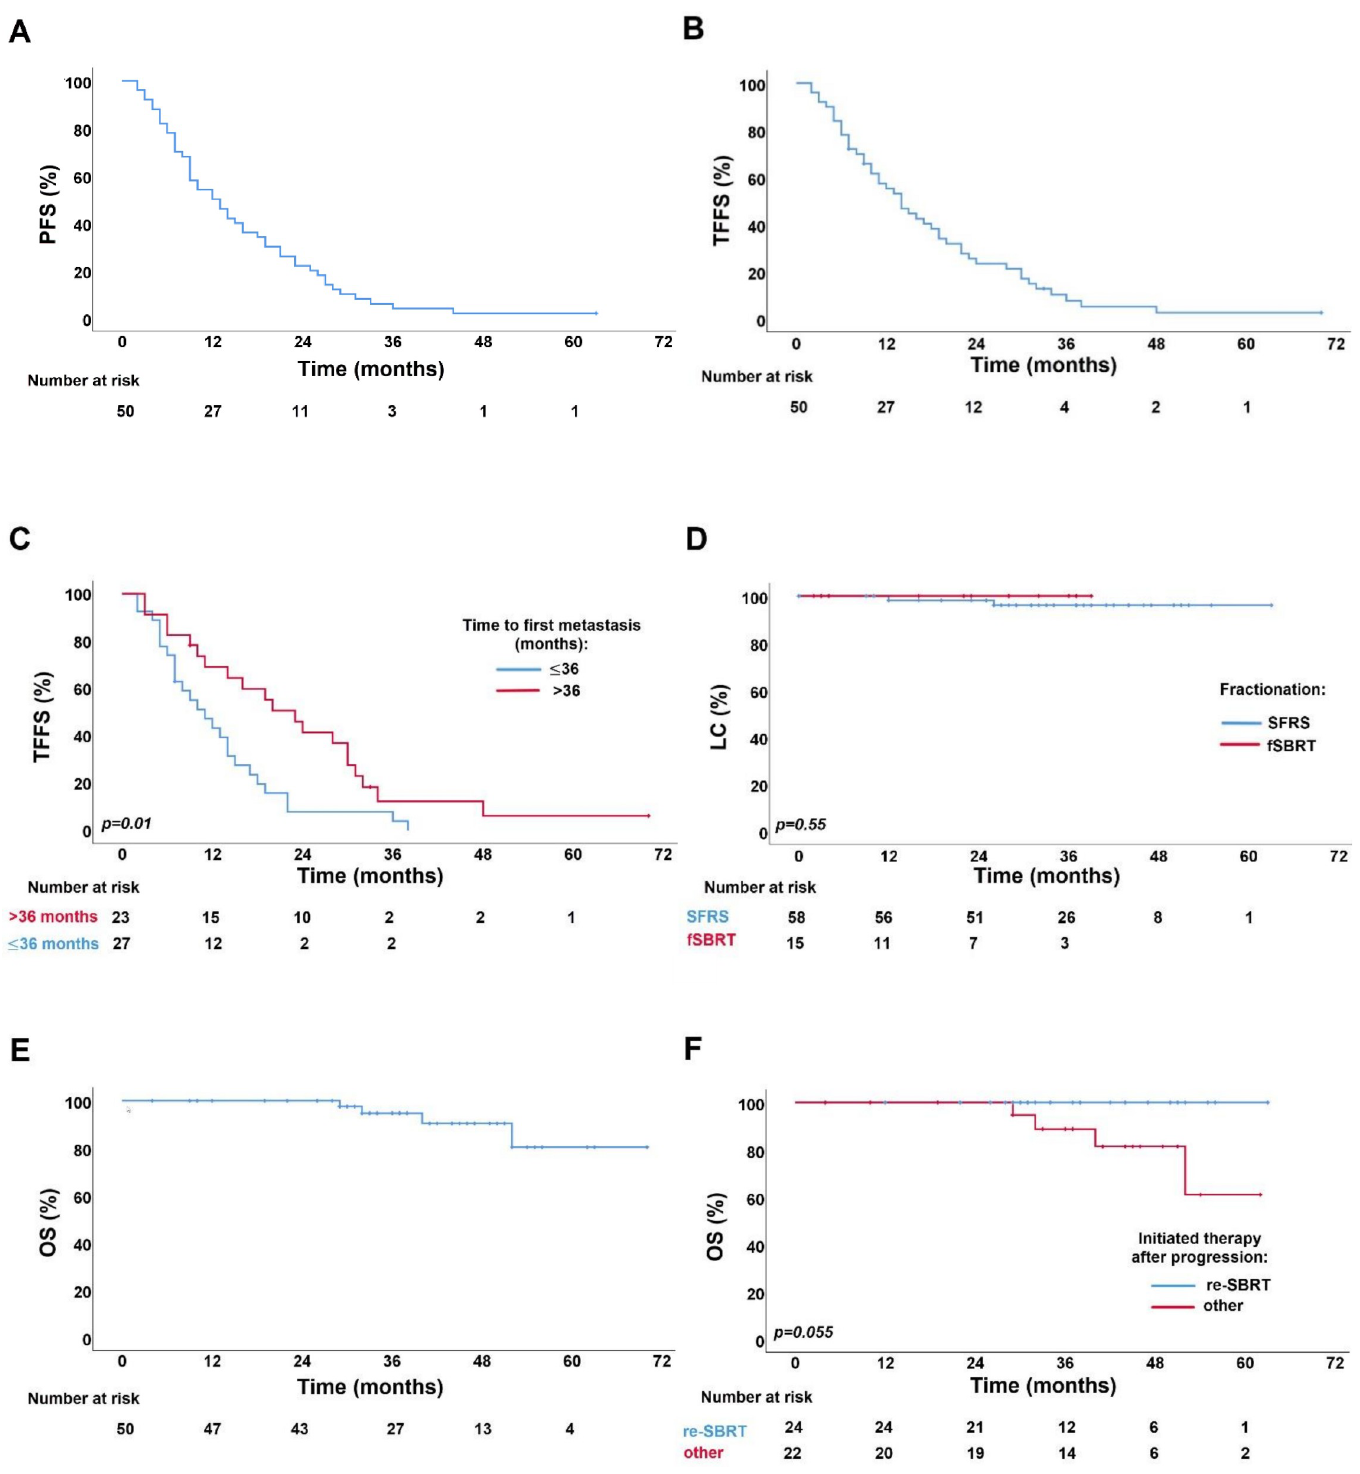
Fig 2. Kaplan–Meier survival curves for: (A) progression-free survival (PFS), (B) treatment failure-free survival (TFFS) (C) treatment failure-free survival by time from PCA diagnosis to first metastasis: > 36 months vs � 36 months, (D) local control (LC) by fractionation schedules: single fraction radiosurgery (SFRS) vs fractionated stereotactic body radiotherapy (fSBRT), (E) overall survival (OS), (F) overall survival by therapy initiated after progression: repeated SBRT (re-SBRT) vs other.